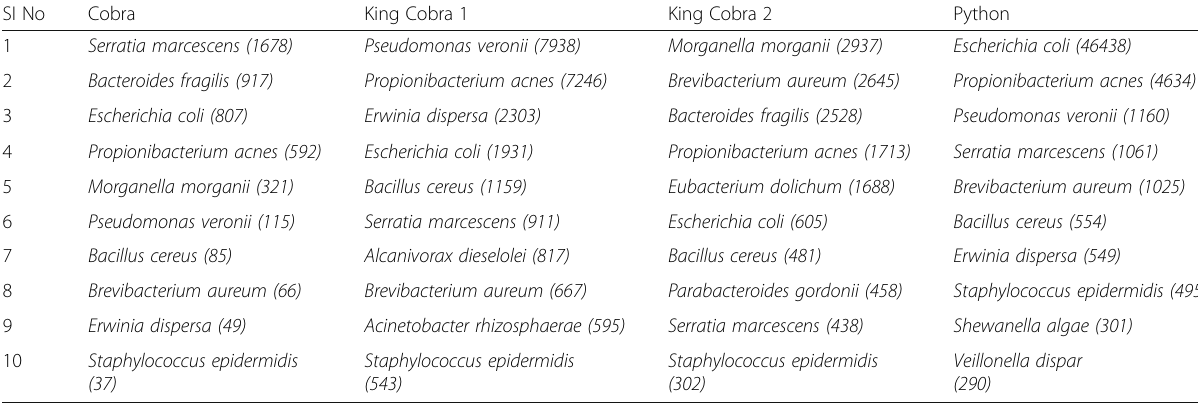
Table 2 Top ten bacterial species present in oral cavities of three snake species in India SI No Cobra King Cobra 1 King Cobra